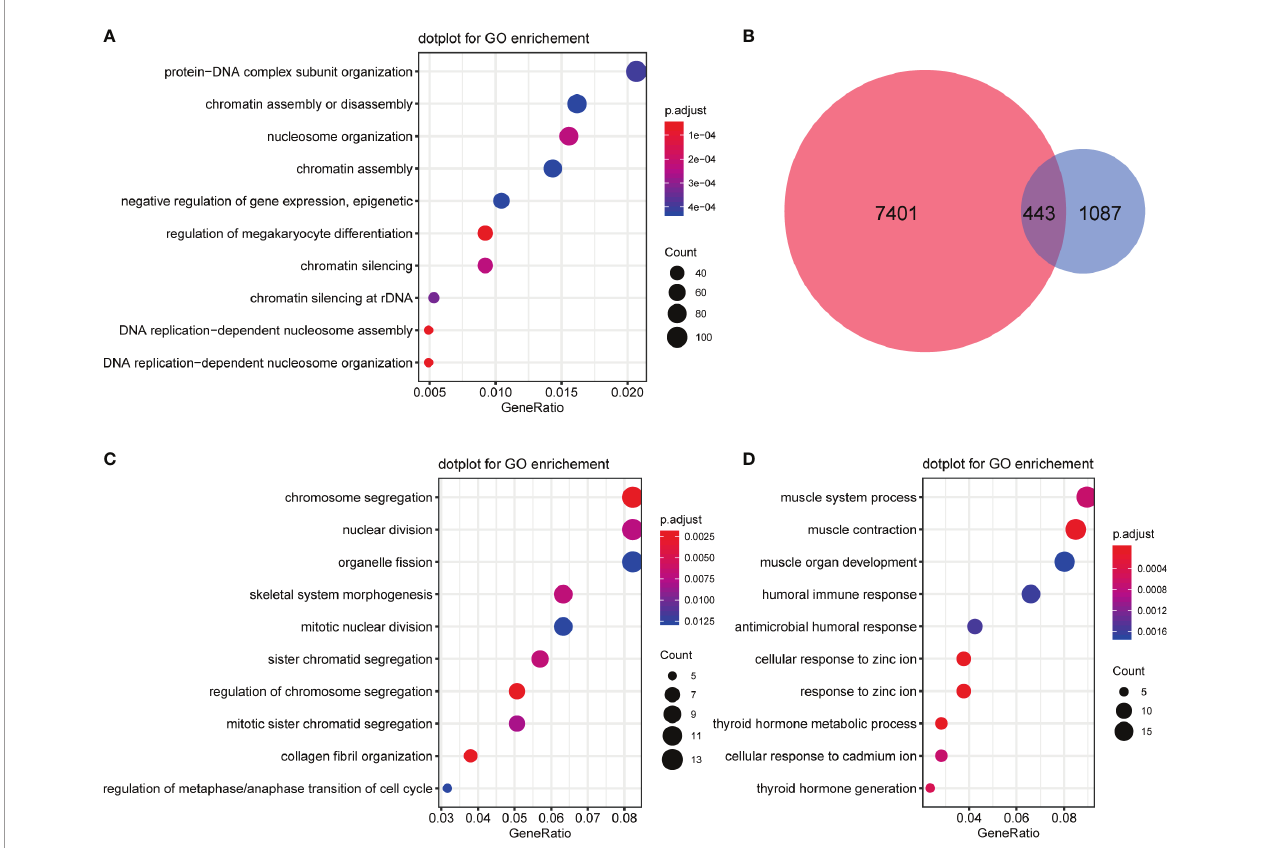
FIGURE 8 | Functional analysis of CNV differential genes. (A) GO enrichment analysis of CNV differential genes. (B) Venn diagrams of CNV differential genes and expression differential genes. (C) GO enrichment analysis of upregulated CNV genes. (D) GO enrichment analysis of downregulated CNV